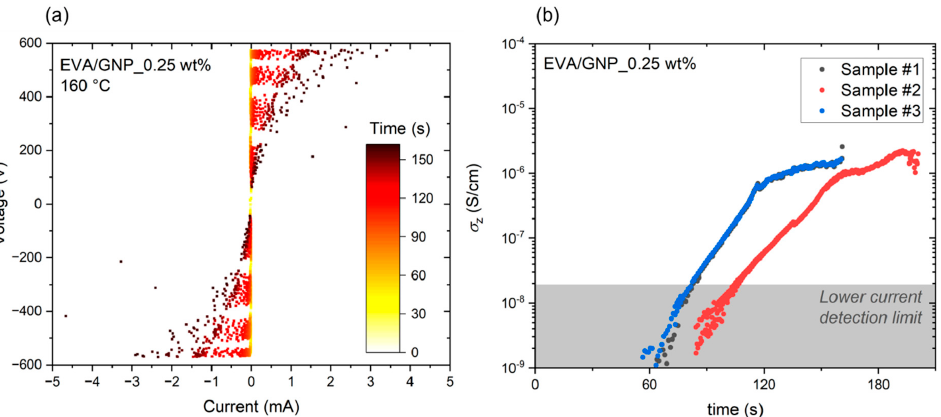
Figure 2. Time-resolved ( a ) voltage and current signals for Sample 1; ( b ) through-direction electrical conductivities of three EVA/GNP_0.25 wt % samples during application of alternating electric field of E 0 = 400 V rms /mm and ω AC = 1 s − 1 . For all three samples, time zero was determined with the time at which the electric field was switched on.